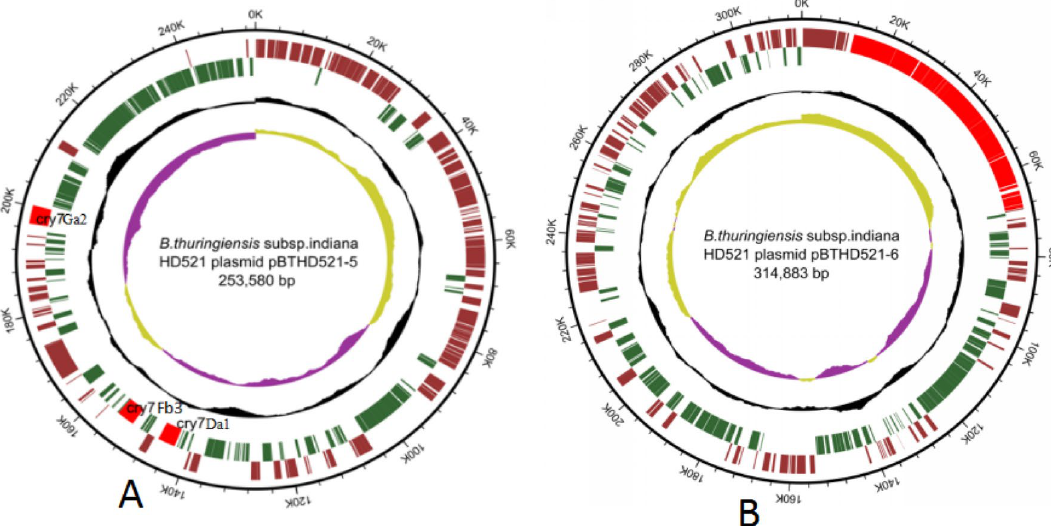
Figure 2. Circular representation of plasmids pBTHD521-5 and pBTHD521-6. ( A ) Circular representation of plasmid pBTHD521-5 displaying relevant genome features. ( B ) Circular representation of plasmidpBTHD521-6 displaying relevant genome